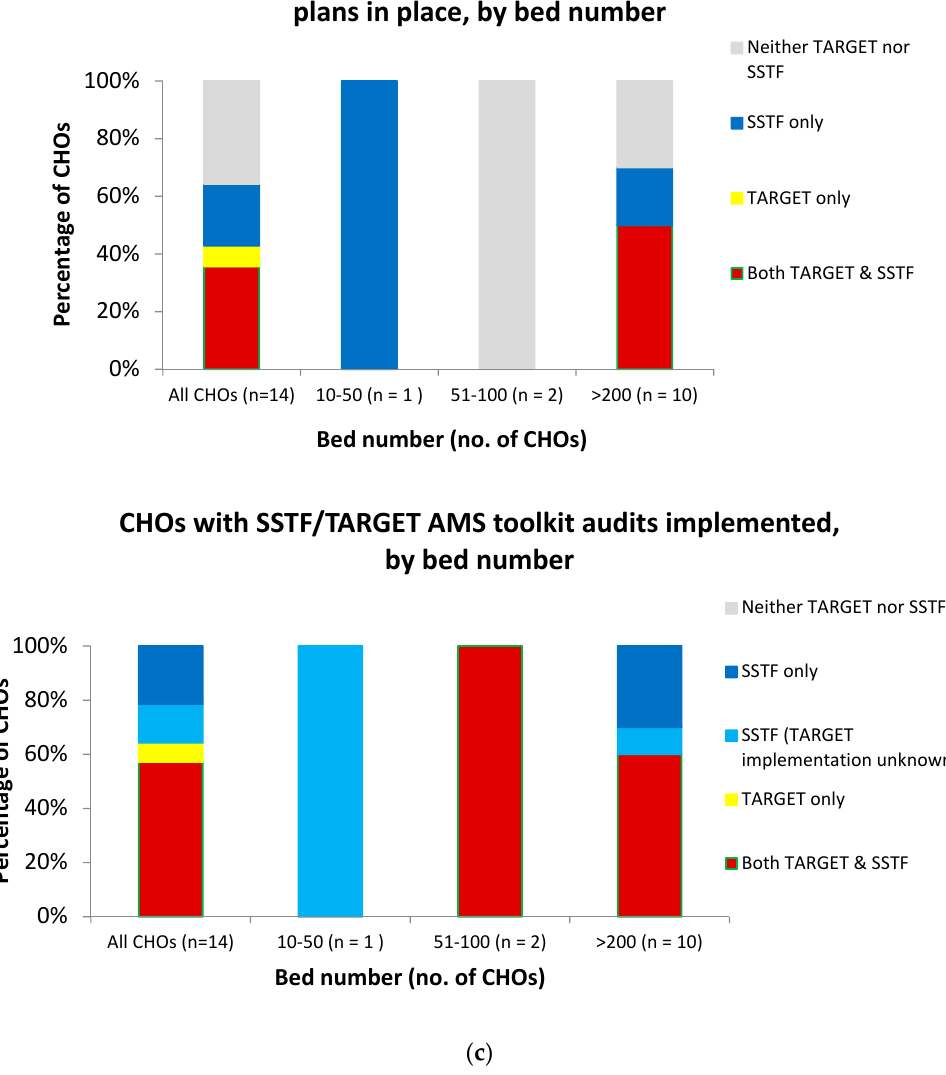
Figure 2. Implementation of Start Smart, then Focus (SSTF) and/or Treat Antibiotics Responsibly, Guidance, Education, Tools (TARGET) antimicrobial stewardship (AMS) toolkits amongst the CHOs that were aware of both toolkits, overall and by CHO bed type and bed number. ( a ) Presence of written action plans in place and implementation of audits across all trusts. ( b ) Presence of written action plans in place and implementation of audits by bed type. ( c ) Presence of written action plans in place and implementation of audits by bed number.